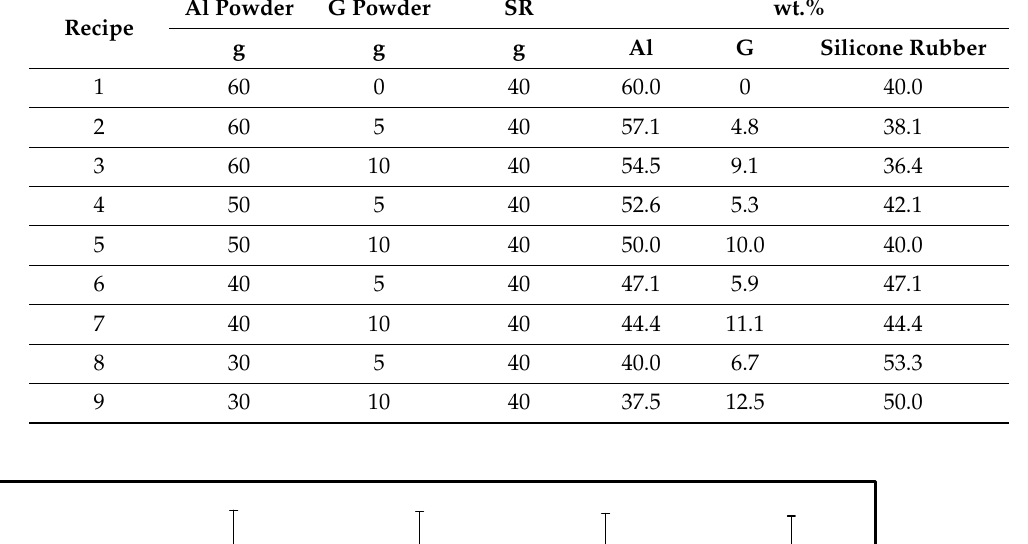
Table 1. Planning table for silicon rubber adding different weight ratios of Al powder and G powder.